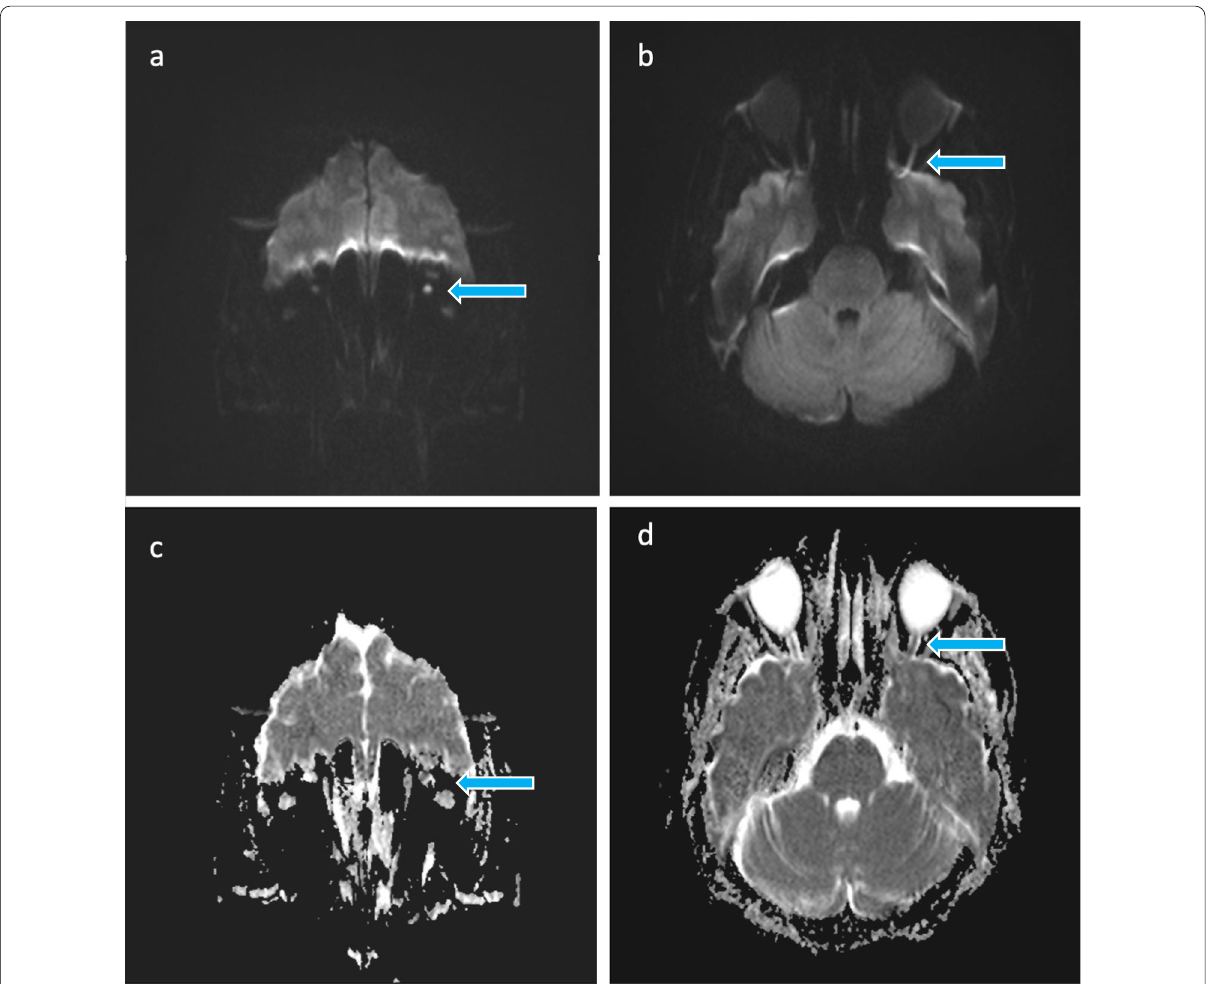
Fig. 1 Initial MRI of the brain. Coronal ( a ) and axial ( b ) diffusion weighted imaging (DWI) b coefficient (ADC) maps ( c, d ) depicting high b